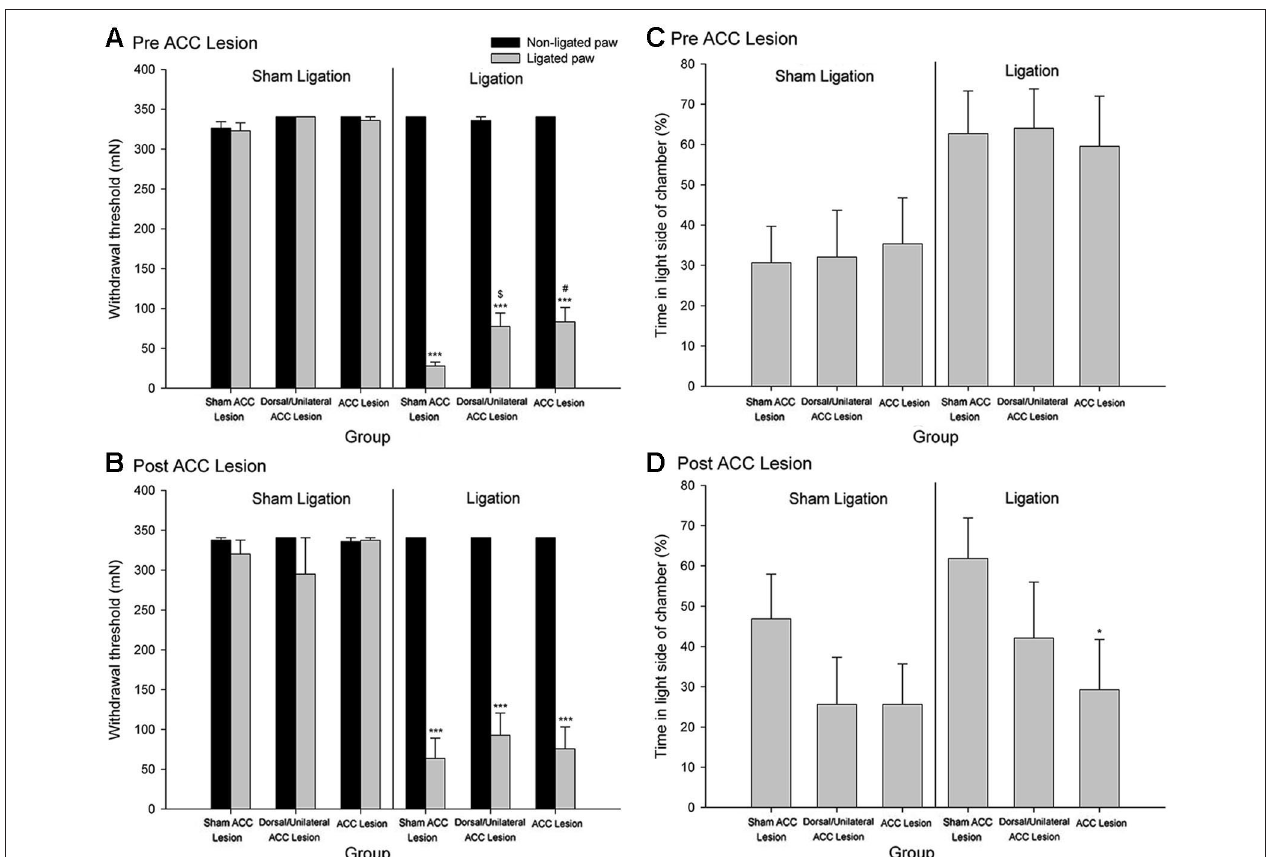
Place Escape/Avoidance Behavior . (C) Mean ± SEM percentage of time within the light side of the test chamber prior to stereotaxic surgery for sham ACC, dorsal/unilateral ACC lesion, or bilateral ACC lesion for animals with sham ligation or ligation of the L5 spinal nerve. (D) Mean ± SEM percentage of time within the light side of the test chamber following stereotaxic surgery for sham ACC, dorsal/unilateral ACC lesion, or bilateral ACC lesion for animals with sham ligation or ligation of the L5 spinal nerve. * p < 0.05 versus sham ACC lesion ligation control (Reprint from LaGraize et al.,